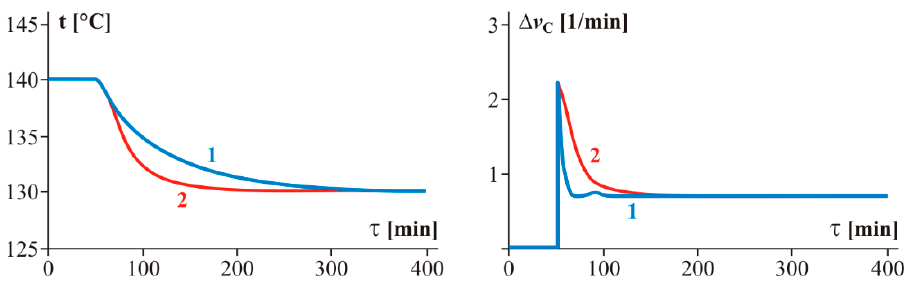
Figure 5. Transients in a closed system with a step change in temperature set point by − 10 °C: 1—the first variant of the algorithm (classic ADAR method); 2—second one (cascade control system).